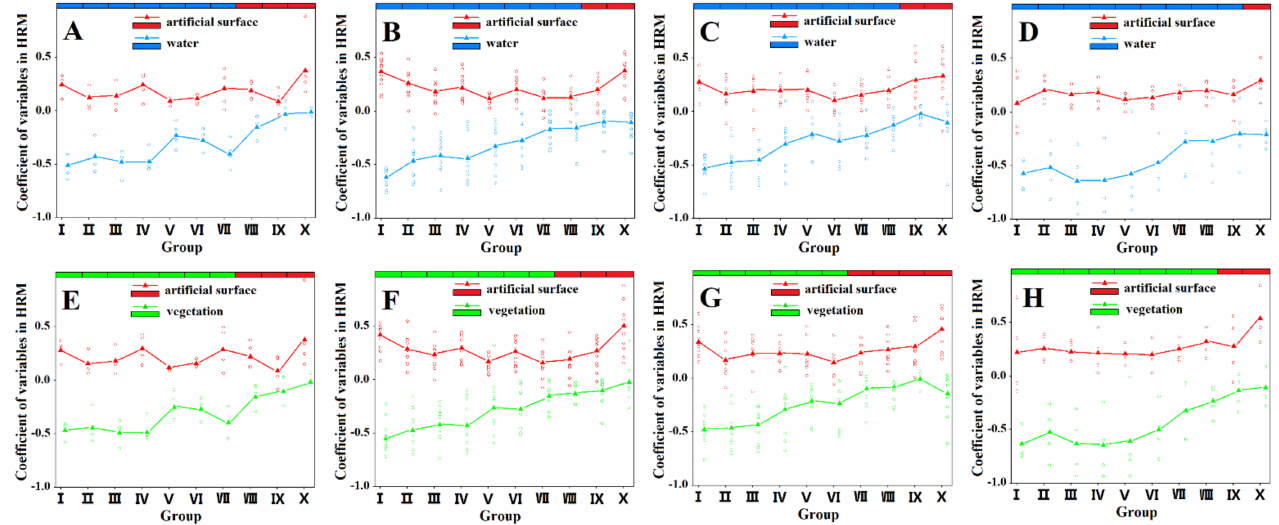
Figure 8. HRM statistics for the first-tier cities ( A , E ), new first-tier cities ( B , F ), second-tier cities ( C , G ), and third-tier cities ( D , H ), respectively. ( A – D ) the AS–water–LST nexus; ( E – H ): the AS–vegetation– LST